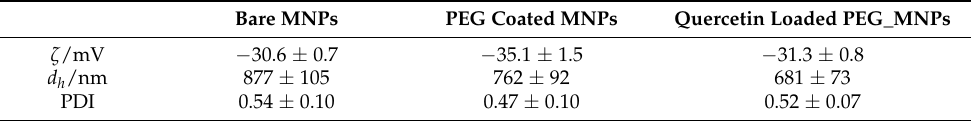
Table 1. Zeta potential and hydrodynamic diameter of bare MNPs, PEG-coated MNPs and quercetin- loaded